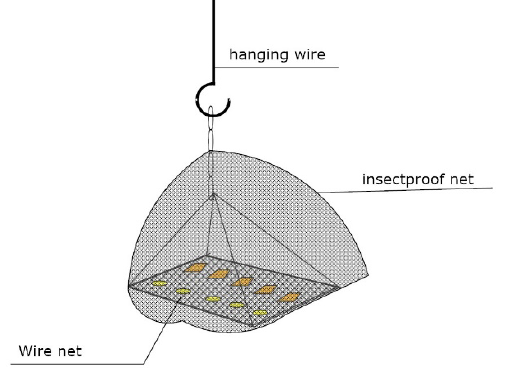
Figure 4. Drying box schematic view.